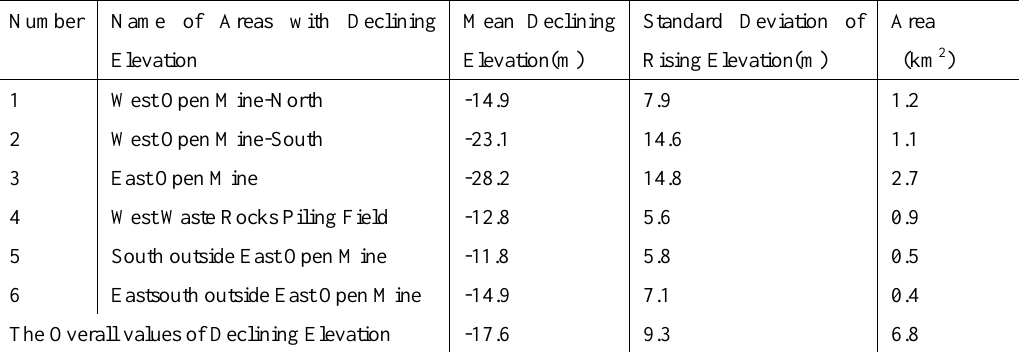
Table 6 Results of the deformation areas with declining elevation using ZY-3 DEM in 2015 and ASTER